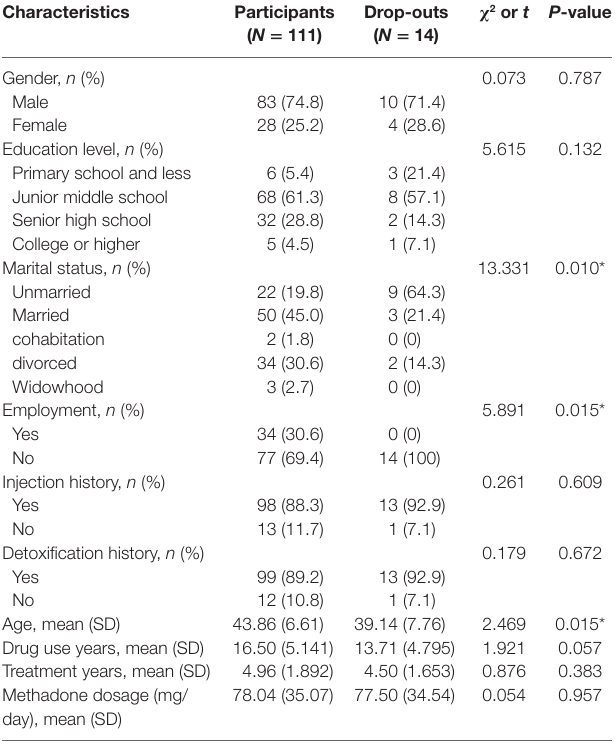
TaBlE 2 | Characteristics of participants and drop-outs. Characteristics